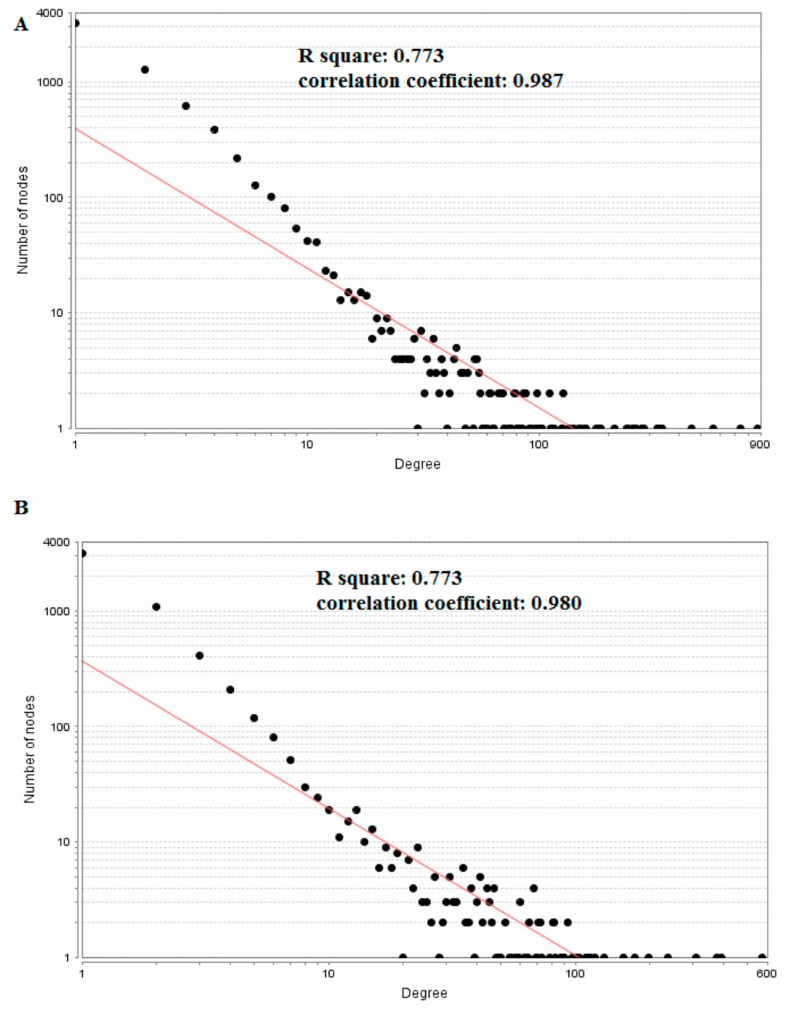
Figure 7. Node degree distribution. ( A ) Up-regulated genes; ( B ) Down-regulated